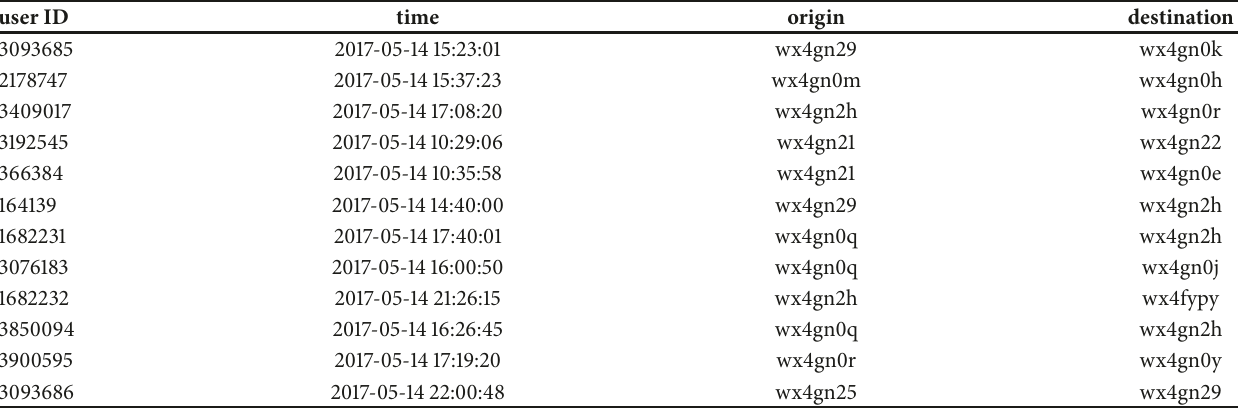
Table 2: Behaviors of user 2730 in 14th May.